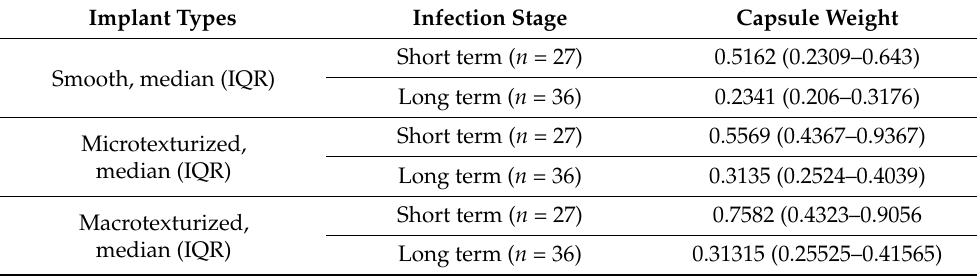
Table 4. Median and interquartile range (IQR) of capsule weights without implant in each infection